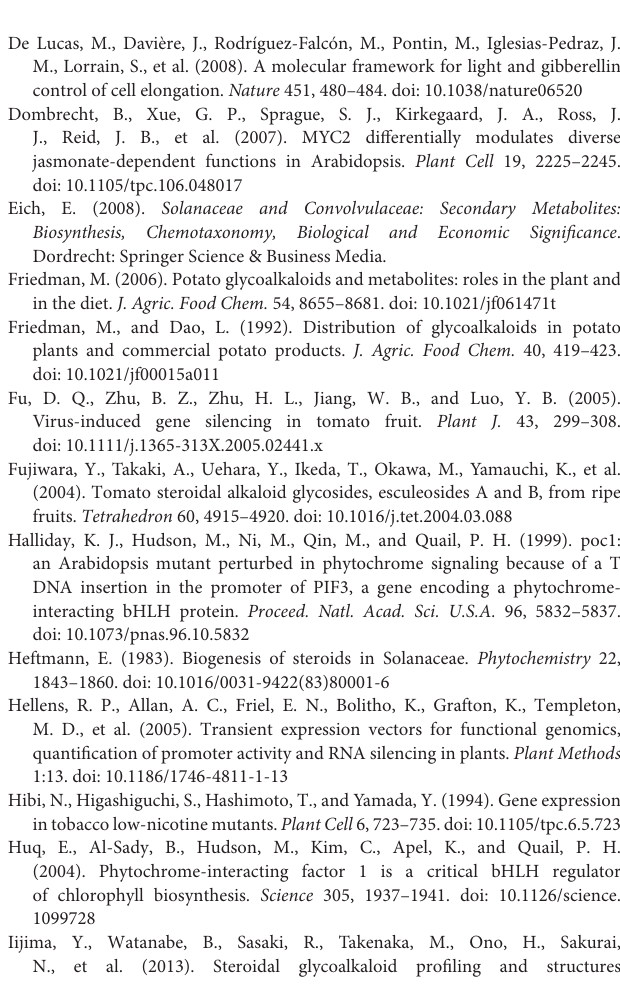
Table S1 | List of primers used in VIGS. The first six primers were used for cloning PDS, HY5 and PIF3 from tomato into the pTRV2 vector. Other primers were used for qRT-PCR. Table S2 | List of primers used in EMSA, ChIP-PCR and DLR. Table S3 | The promoter region containing some cis -acting elements. ATG: initiation codon; The cis -acting element (CACGTG) is highlighted in red and the mutated nucleotides in the promoter sequences are AAAAAA. Table S4 | Biotin-labeled probes were used for EMSA. G box (CACGTG), CG hybrid (GACGTG), CA hybrid (GACGTA), and Z box (TACGTG) are known as HY5 and PIF3 consensus binding